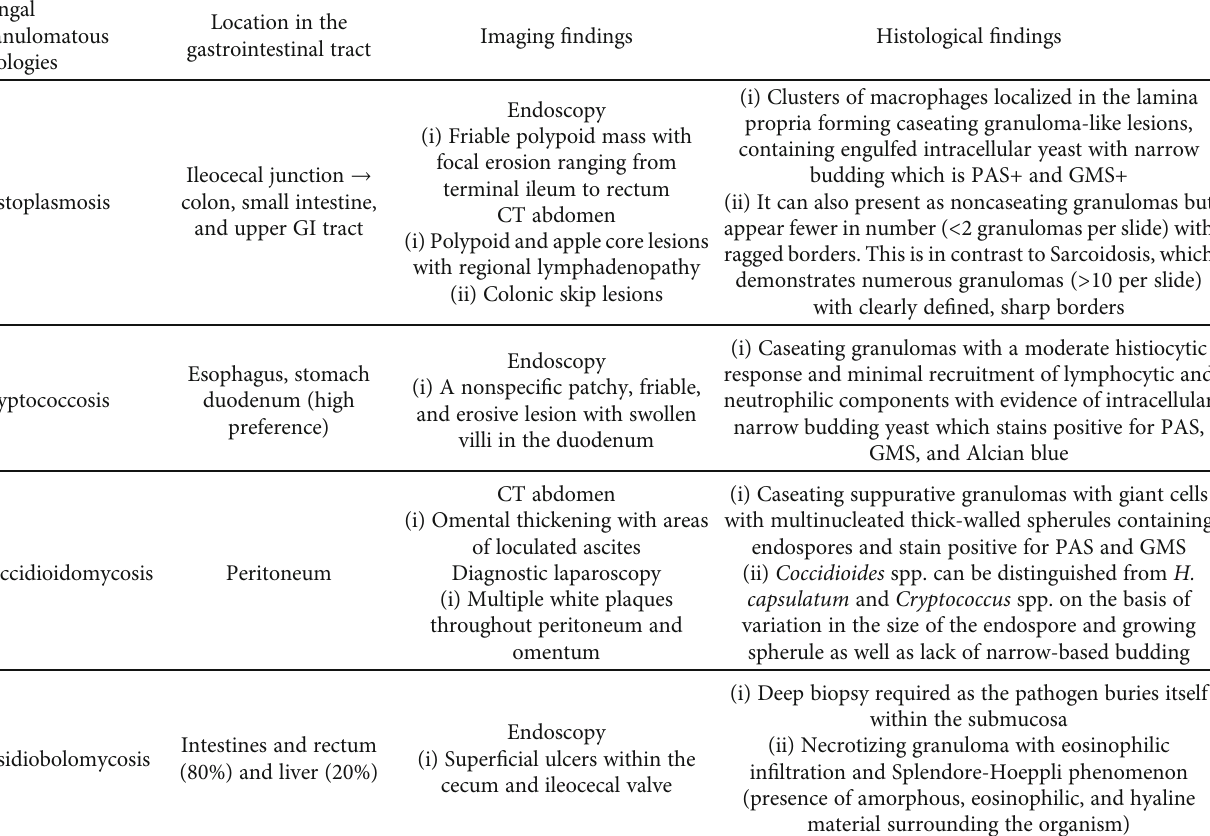
Table 2: Comparison of imaging and microscopic fi ndings together with regions of the gastrointestinal tract a ff ected by fungal causes of granulomatous